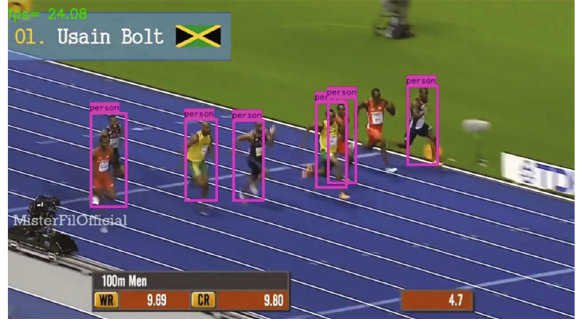
Figure 5: Video measurement e ff ect